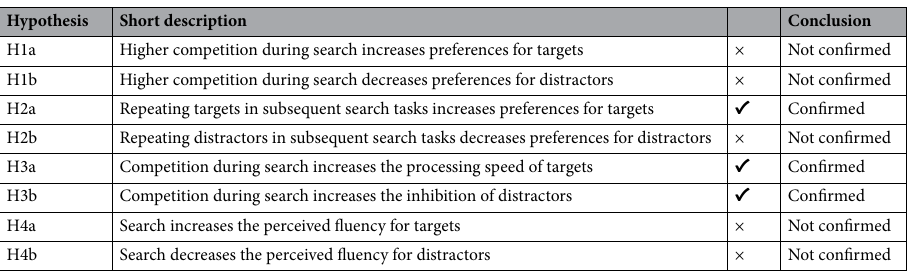
Table 1. Summary of hypotheses and